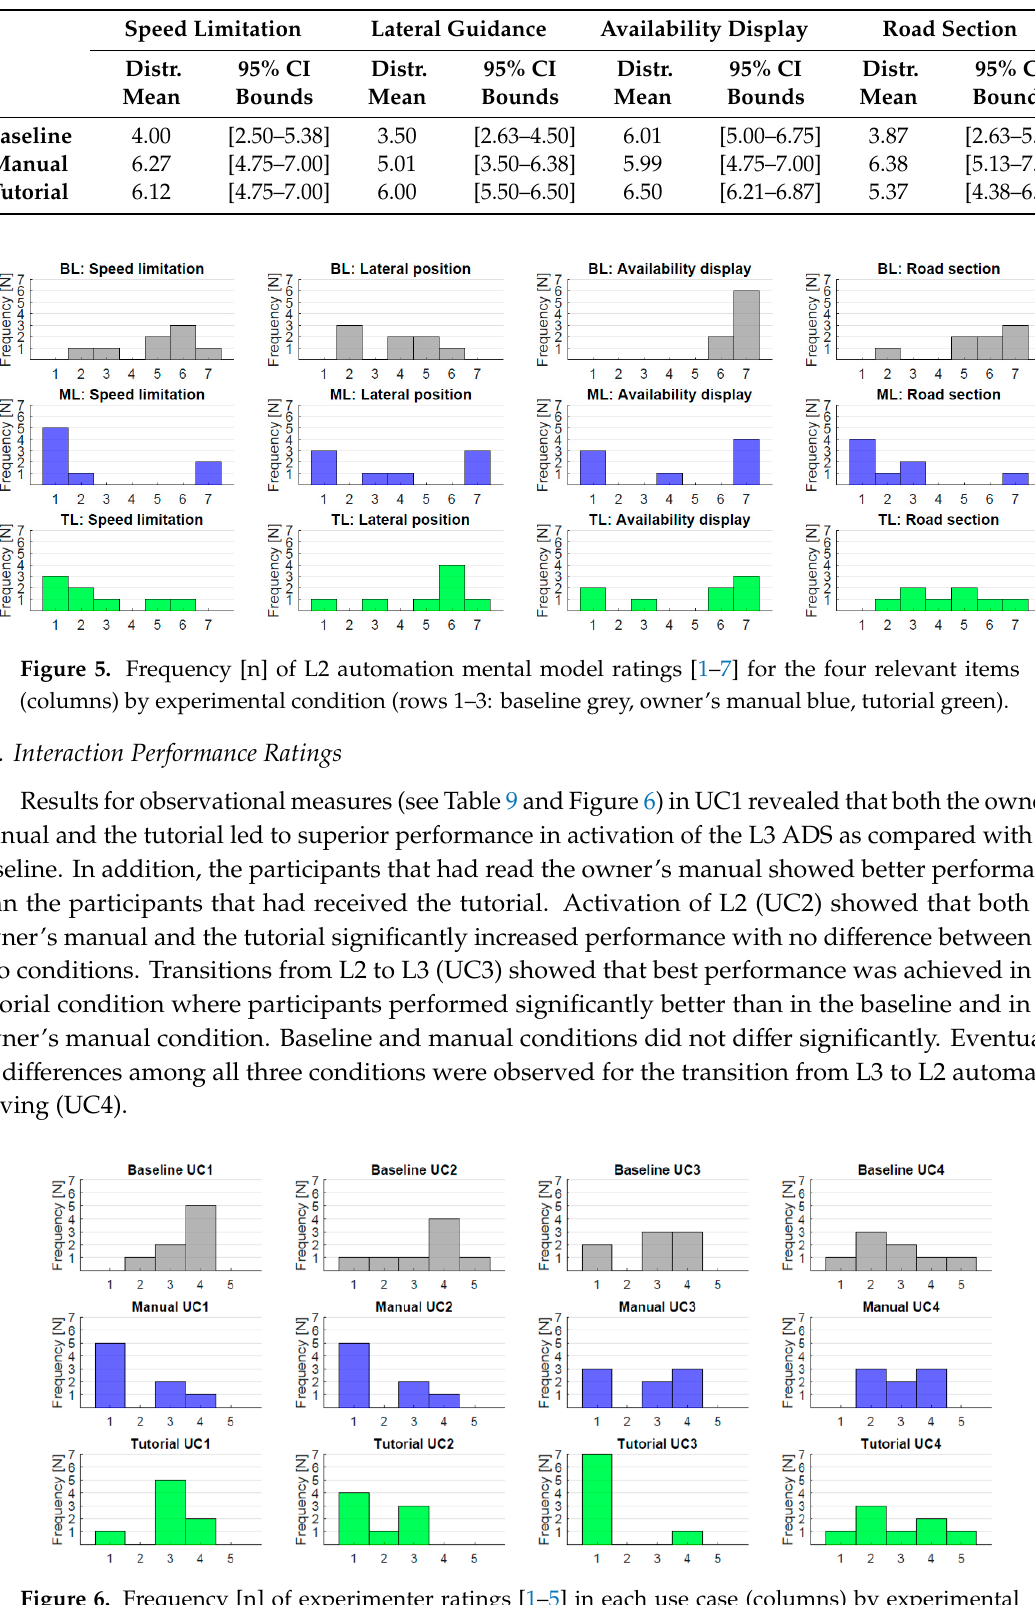
Table 8. Means and 95% CI upper and lower bounds of bootstrapped mental model distributions for the four relevant items on L3 automation by the three experimental conditions.